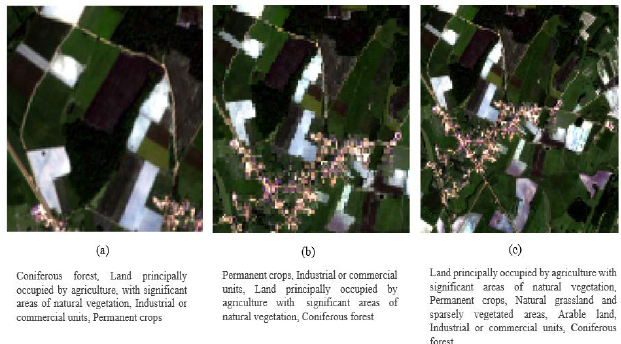
Figure 6 . a, b, c patches with dimensions 60,90,120